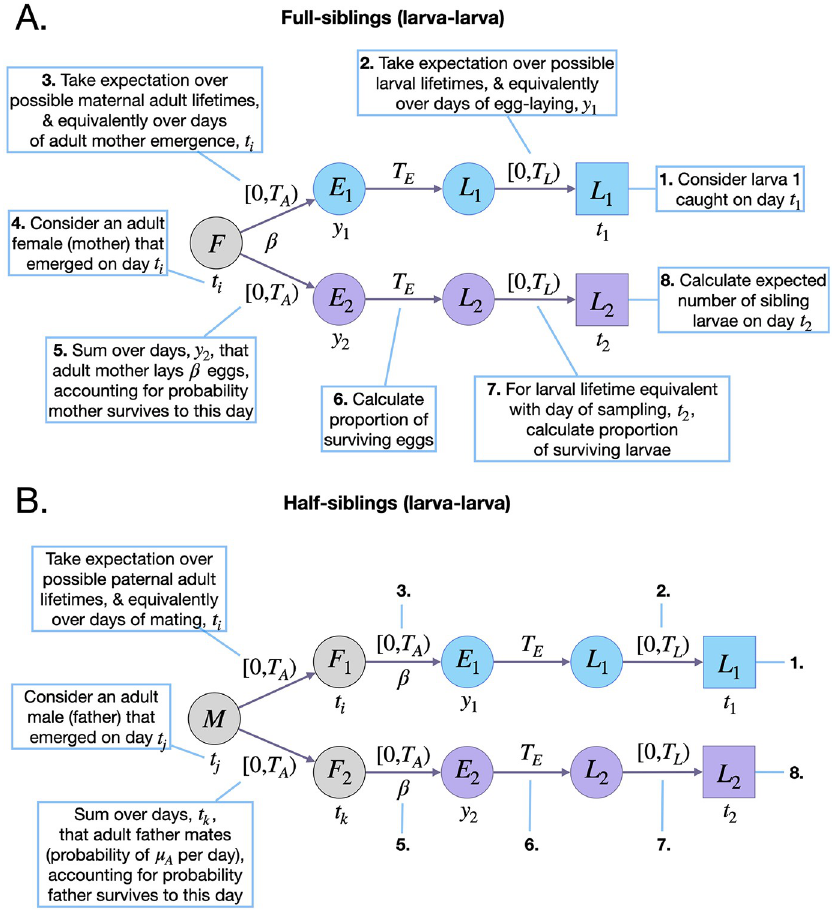
Fig 3. Schematic representation of sibling kinship probabilities. Parameters and state variables are as defined in Table 1 and §2.1. Subscript 1 refers to the reference sibling (blue), and subscript 2 refers to the sibling from whose perspective the probabilities are calculated (purple). Circles represent living individuals and squares represent sampled individuals. The reference sibling is sampled on day t 1 and laid on day y 1 . Sibling 2 is sampled on day t 2 and laid on